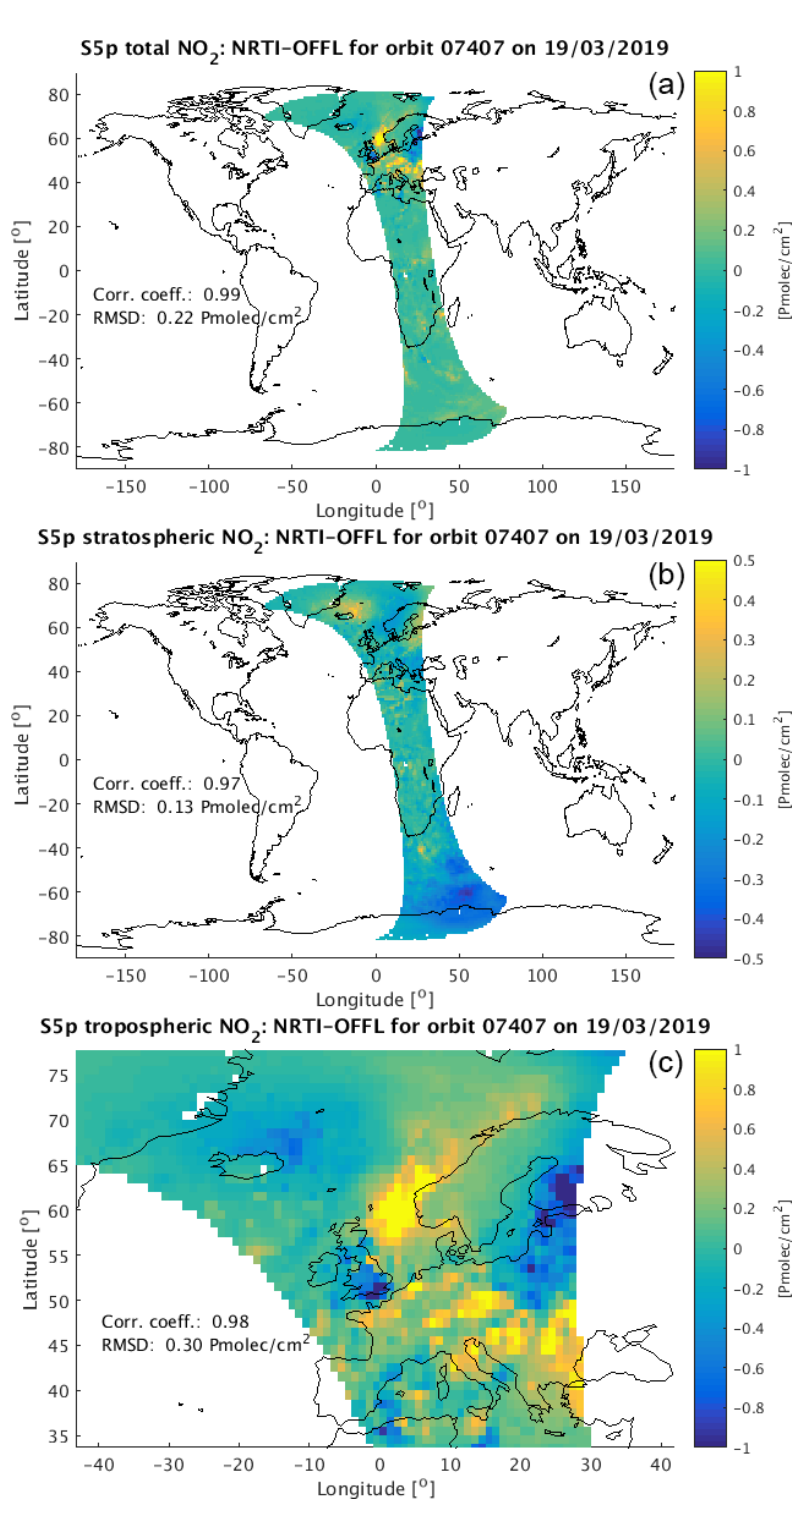
Figure 3. Maps of the difference between the NRTI and OFFL NO 2 data values for S5P orbit no. 07407 on 19 March 2019. Difference between (a) total column values and (b) stratospheric column values. (c) Close-up of the difference in tropospheric column values over western